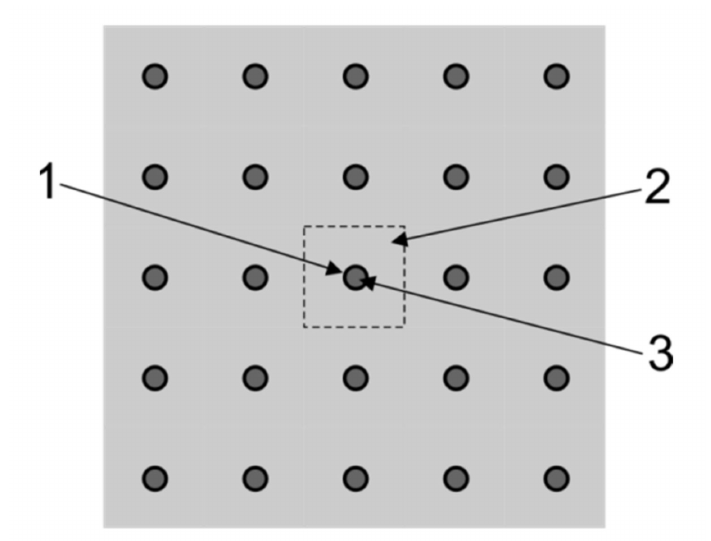
Figure 14. Schematic illustration of the cross-section through the tube bundle and phase-change ma- terial (PCM): 1 —tube, 2 —PCM, 3 —heat transfer fluid (HTF). (The dashed line indicates a substitute thickness of the PCM assigned to each